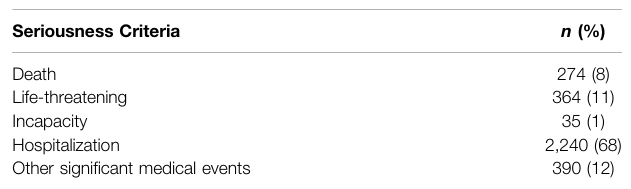
TABLE 3 | Seriousness criteria of serious DDI-ADR n (cid:1) 3,303. Seriousness